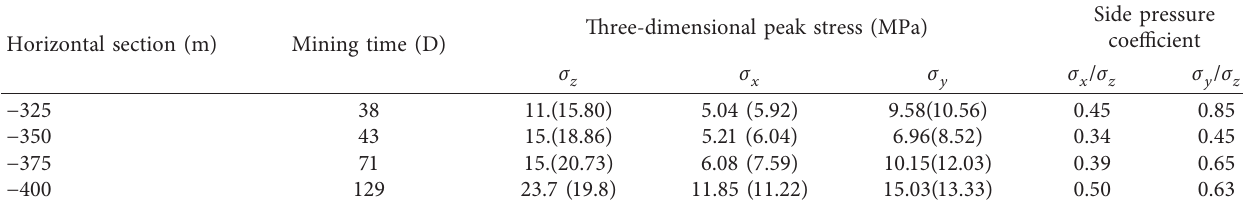
Table 1: Three-dimensional peak stress during the mining